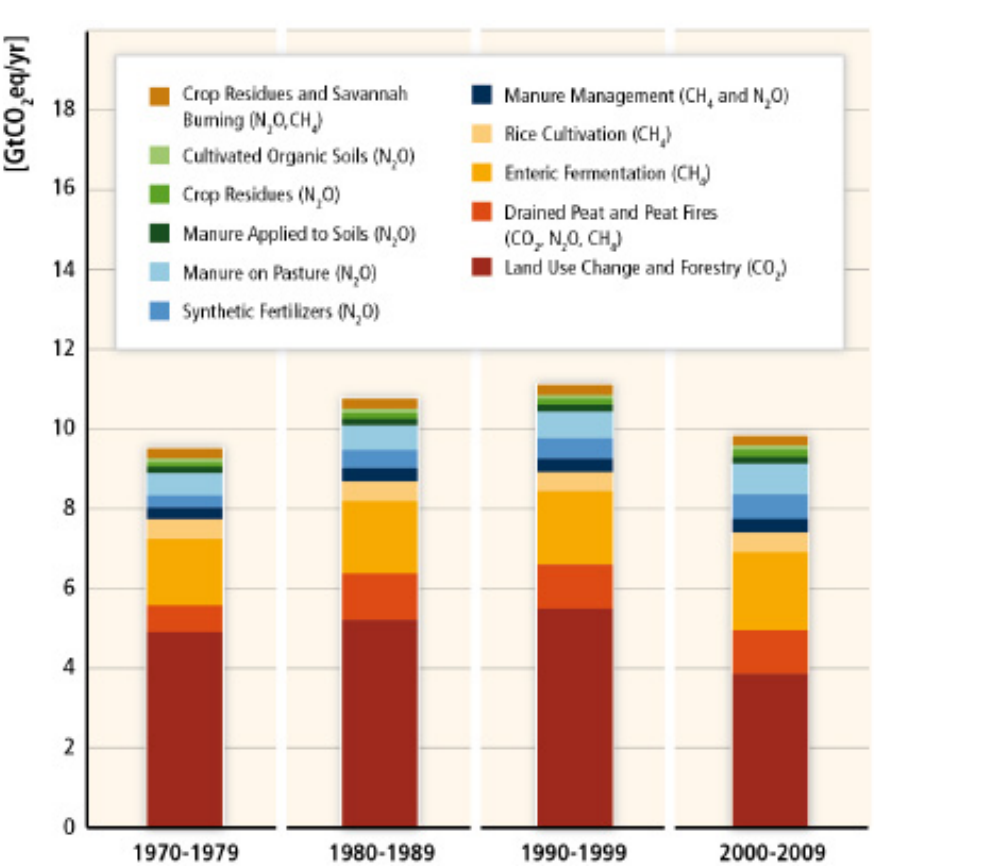
Figure 2: Greenhouse gas emissions from agriculture, forestry, and land use change. Source : Smith P., et al.